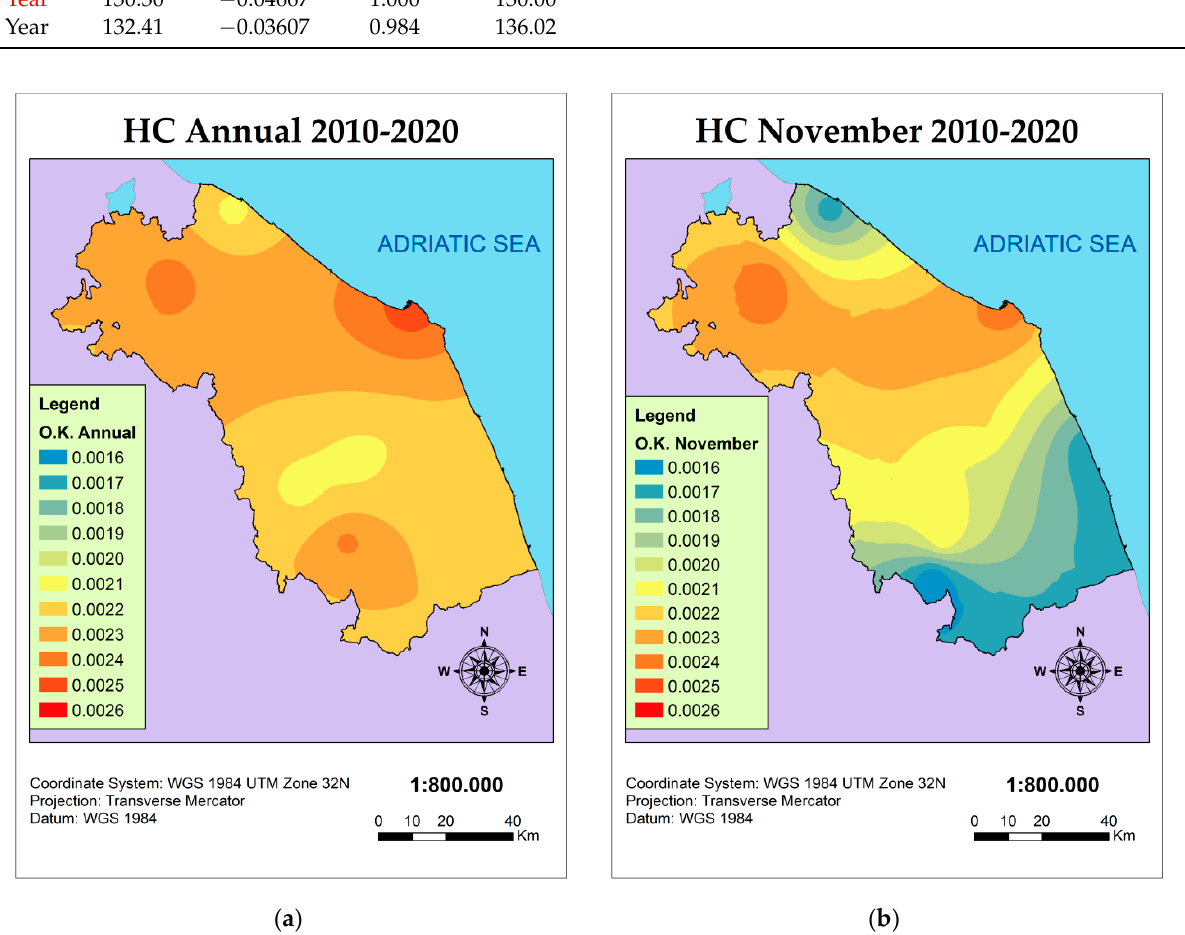
Figure 5. Interpolation of the HC from 2010 to 2020, in the study area for the year ( a ) and for November ( b ).